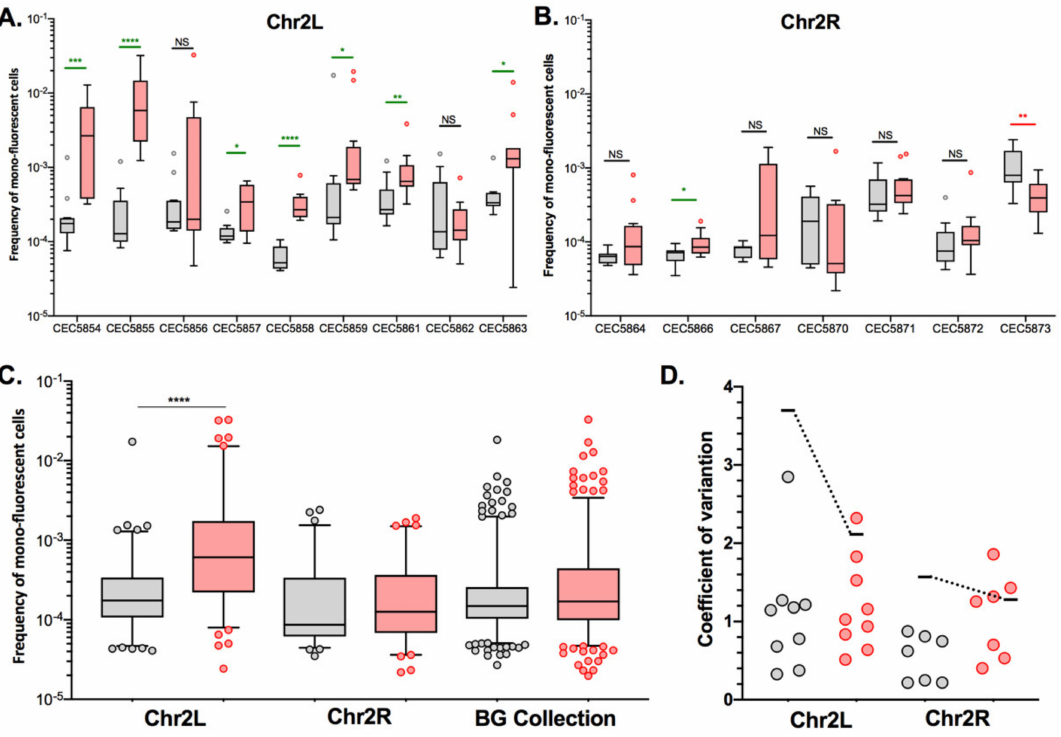
Figure 7. Effect of hydrogen peroxide on LOH frequency in C. albicans . Median frequencies of mono-fluorescence, LOH frequency, in YPD (gray), and 4 mM H 2 O 2 (red) represented as box plots and whiskers (Tukey). LOH frequencies were assessed by fluctuation analysis ( n = 12). Differences of median LOH frequencies, between control condition (YPD) and the oxidative stress condition were evaluated using the Mann–Whitney test (NS p > 0.05, * p < 0.05, ** p < 0.01, *** p < 0.001, and **** p < 0.0001). Significant augmentation and reductions of LOH frequencies are identified in green and red, respectively, for panels ( A , B ). ( A ) Representation of median LOH frequencies for 9 strains possessing the BFP/GFP LOH reporter system on Chr2L. ( B ) Representation of median LOH frequencies for 7 strains possessing the BFP/GFP LOH reporter system on Chr2R. ( C ) Heterogeneity and median LOH frequency of Chr2L (9 strains), Chr2R (7 strains), and Blue-Green (BG) collection (14 strains) by pooling of multiple strains. ( D ) Heterogeneity of LOH frequencies represented by coefficients of variation. Each circle represents the coefficient of variation for a single strain while the variation between strains is shown by a horizontal